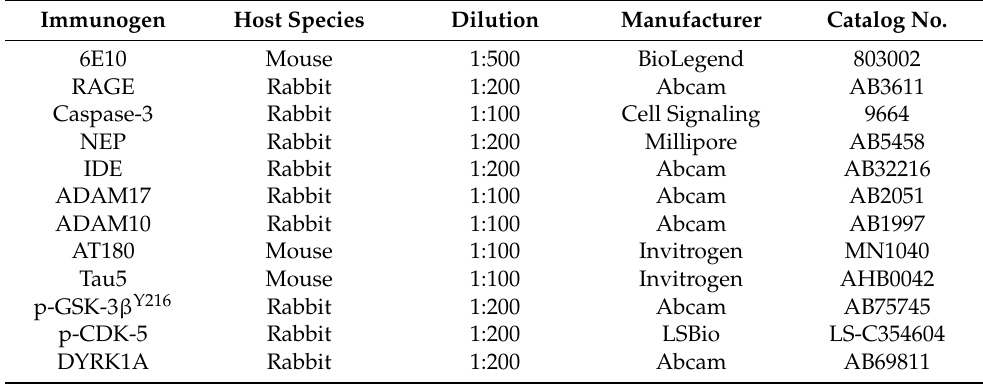
Table 1. Primary